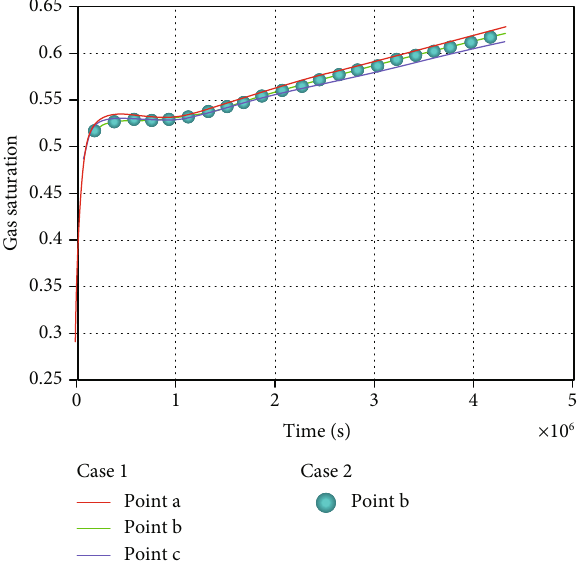
Figure 14: Temporal evolution of gas saturation at point b in case 1 and points a, b, and c in case